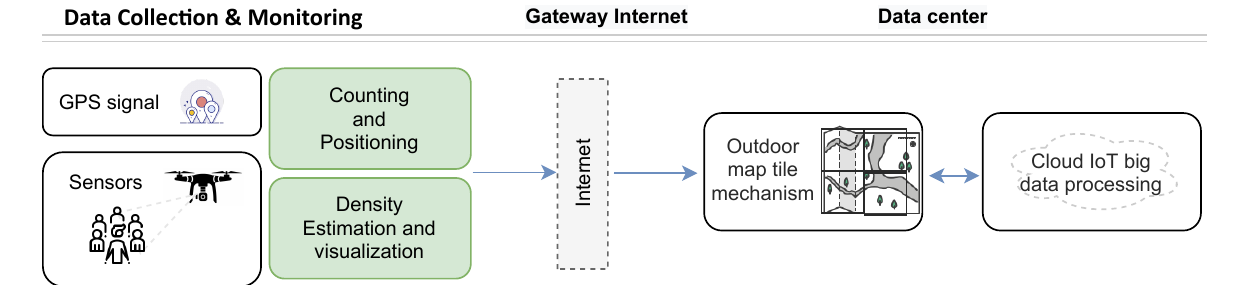
Figure 1. The task automation of intelligent monitoring of outdoor crowd density system.